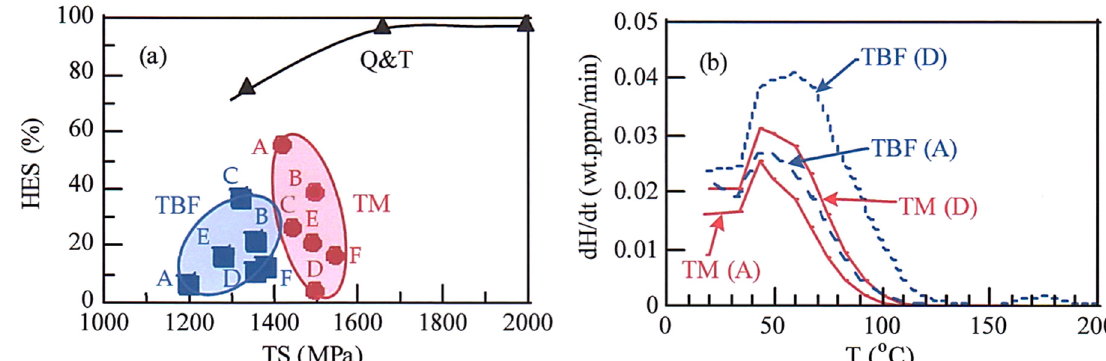
Figure 14. ( a ) Relationship between hydrogen embrittlement susceptibility (HES) and tensile strength (TS) [63] and ( b ) hydrogen evolution curves of 0.2%C–1.5%Si–1.5%Mn–(0–1.0)%Cr–(0–0.2)%Mo–0.05%Nb TM steels subjected to DQ-P process ( T p = 250 ° C, 300 ° C, ● ) and TBF steels ( T IT = 350 ° C , ■ ) and 0.40%C–0.16%Si–1.44%Mn Q&T steel ( T T = 200 ° C to 400 ° C, ▲ ) [63]. A: 0.20%C–1.50%Si–1.50%Mn, B: 0.20%C–1.52%Si–1.50%Mn–0.05%Nb, C: 0.21%C–1.49%Si–1.50%Mn–0.5%Cr–0.05%Nb, D: 0.20%C–1.49%Si–1.50%Mn–1.0%Cr–0.05%Nb, E: 0.18%C–1.48%Si–1.49%Mn–1.0%Cr–0.2%Mo–0.05%Nb, F: 0.21%C–1.49%Si–1.49%Mn–1.52%Ni–1.0%Cr–0.2%Mo–0.05%Nb.